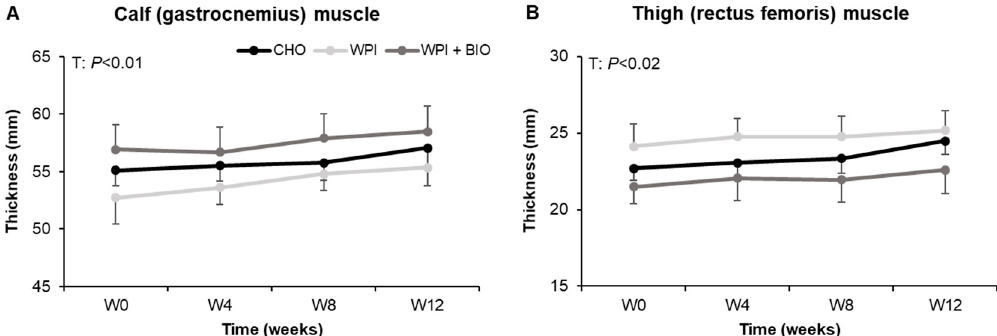
Figure 2. Thickness of ( A ) calf and ( B ) thigh muscles assessed by ultrasonography in elderly subjects with limited mobility treated with a combination of EMS and nutritional supplement: CHO, WPI or WPI + BIO for 12 weeks. Values are means ± SEM (n = 10–15). The time statistical effects (T) are reported for each muscle (Wilcoxon tests). BIO: bioactives, CHO: carbohydrates, WPI: whey protein isolate.